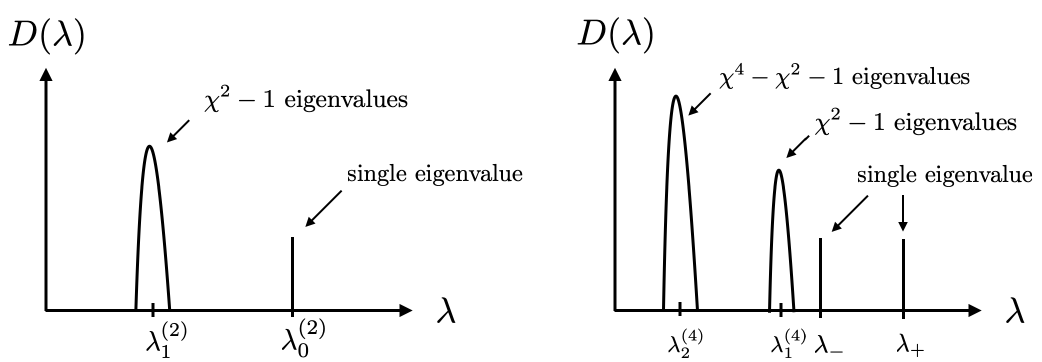
Figure 11 . A sketch of the spectrum we obtained for m = 2 (left) and m = 4 (right). The eigenvalues of k > 0 sectors are depicted here as having a small width. This is found by including the finite external bond dimension effects, which we will study in section